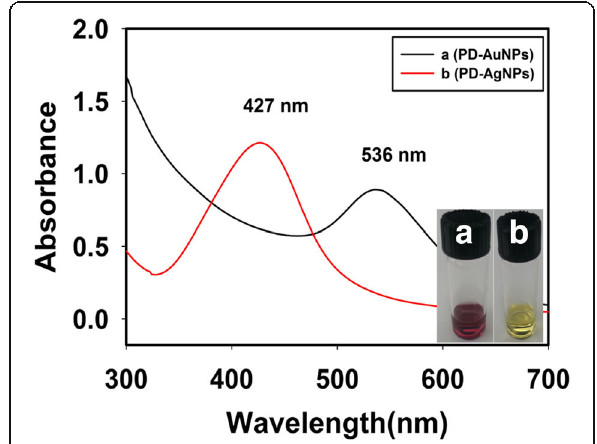
Fig. 2 UV-Visible spectra. a PD-AuNPs and b PD-AgNPs